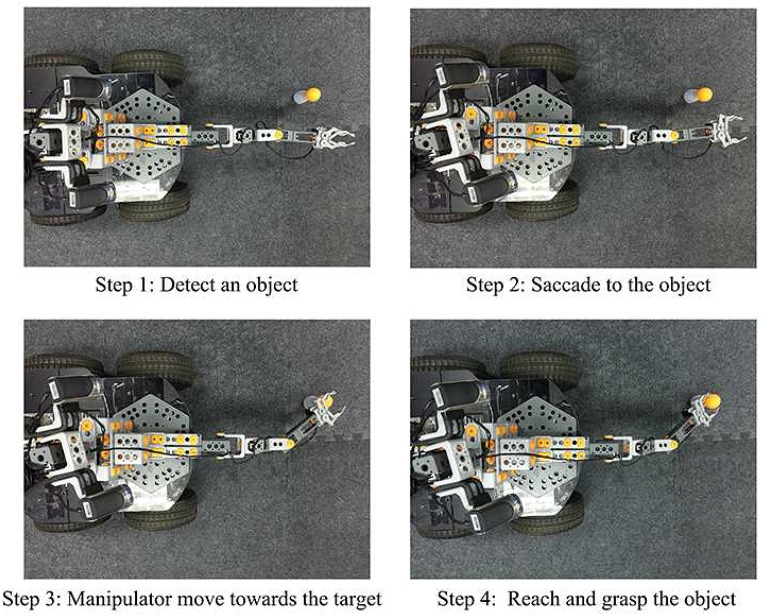
The procedure in simple game mode.